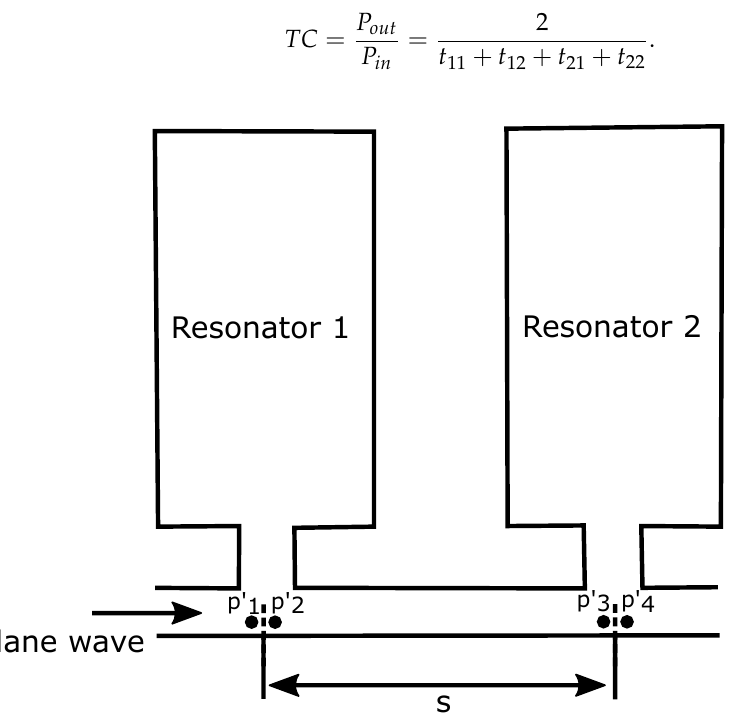
Figure 4. Schematics of two Helmholtz resonators mounted in